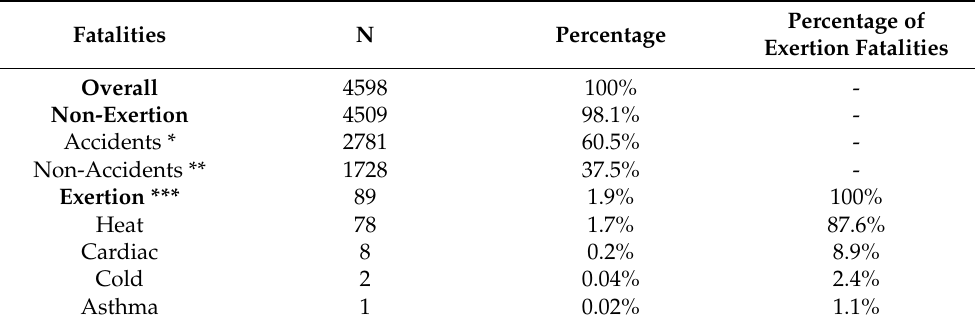
Table 3. Nature of OSHA-reported exertion-related and non-exertion-related fatalities in OSHA Fatality Inspection Database (2017–2020).